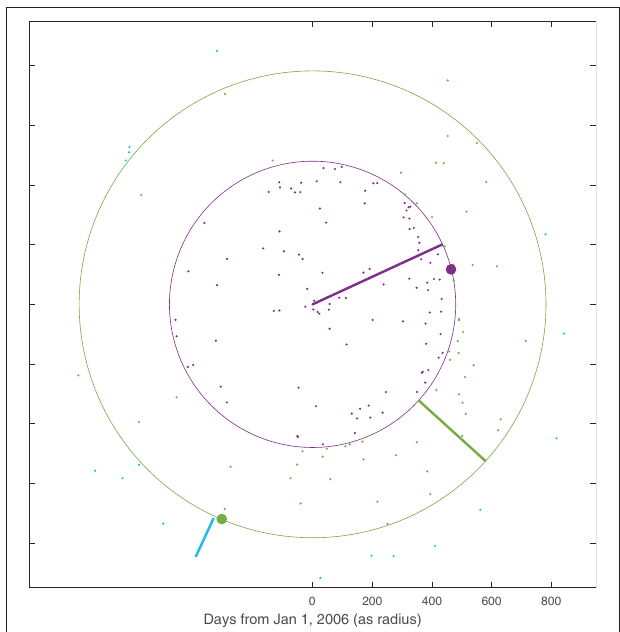
FIGURE 14 | Same posterior draw of forecast PDC activity as in Figure 13 , for the period of 1 st January 2006 through 1 st August 2008. Time in days since 1 st January 2006 is shown radially on linear scale. Colored radial µ e segments indicate central directions , which change at epoch-ending { } T e of events V j > (cid:127) times τ j 6 10 6 m 3 (indicated by concentric circles, = = · with direction of major flows shown as filled circles). Individual PDC events are shown as colored